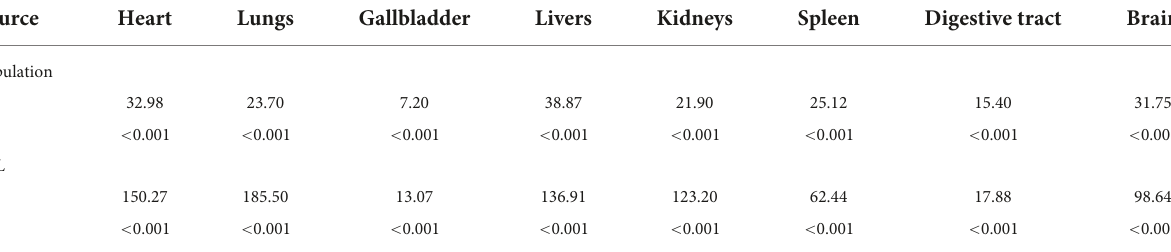
TABLE 1 The variations of organs size in Bufo andrewsi among 14 populations when correcting for body size using one-way analyses of